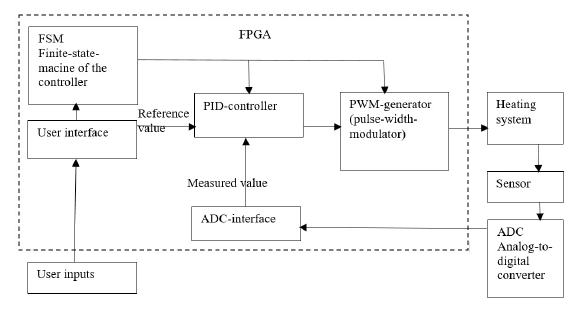
Figure 4: PID-controller in closed loop and what are inside FPGA